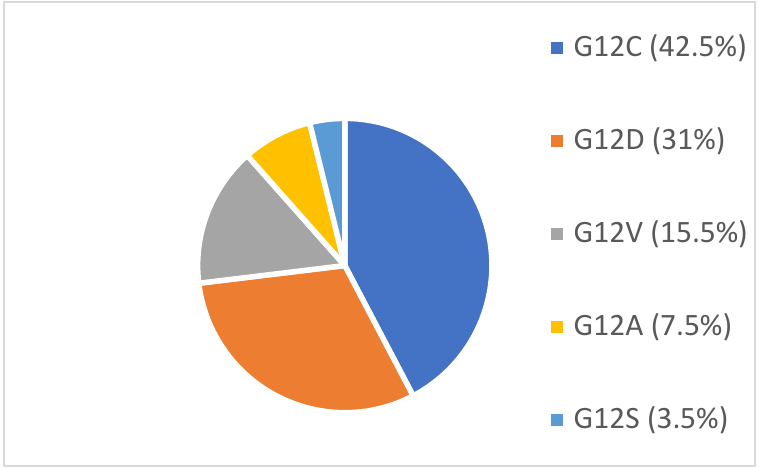
Figure 1. Incidence of KRAS molecular aberrations.